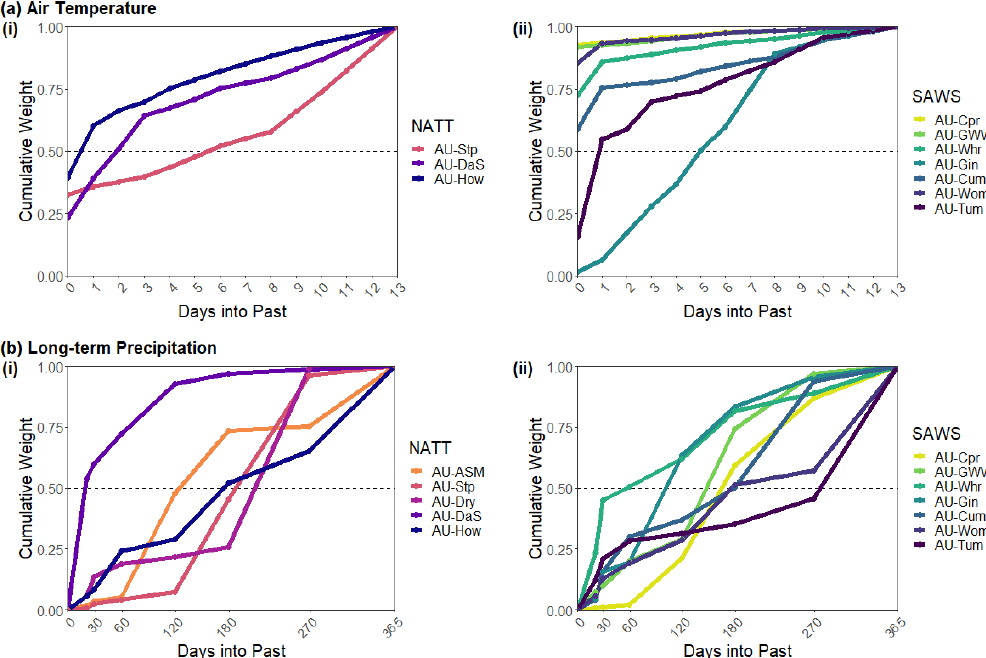
Figure 3. Cumulative mean weights from the NEE EM model for (a) air temperature and (b) long-term precipitation. Sites are split into the (i) NATT and (ii) SAWS groups for each climate predictor. Within each group, sites are ordered by mean annual precipitation, with darker colours indicating higher MAP. Only sites where the climate variable is significant in Fig. 2a are included. The dashed line at a cumulative weight of 0.5 indicates the threshold for the critical lag period. Where the cumulative weights cross this line is considered the timescale of the environmental memory effect for each site for the climatic driver in